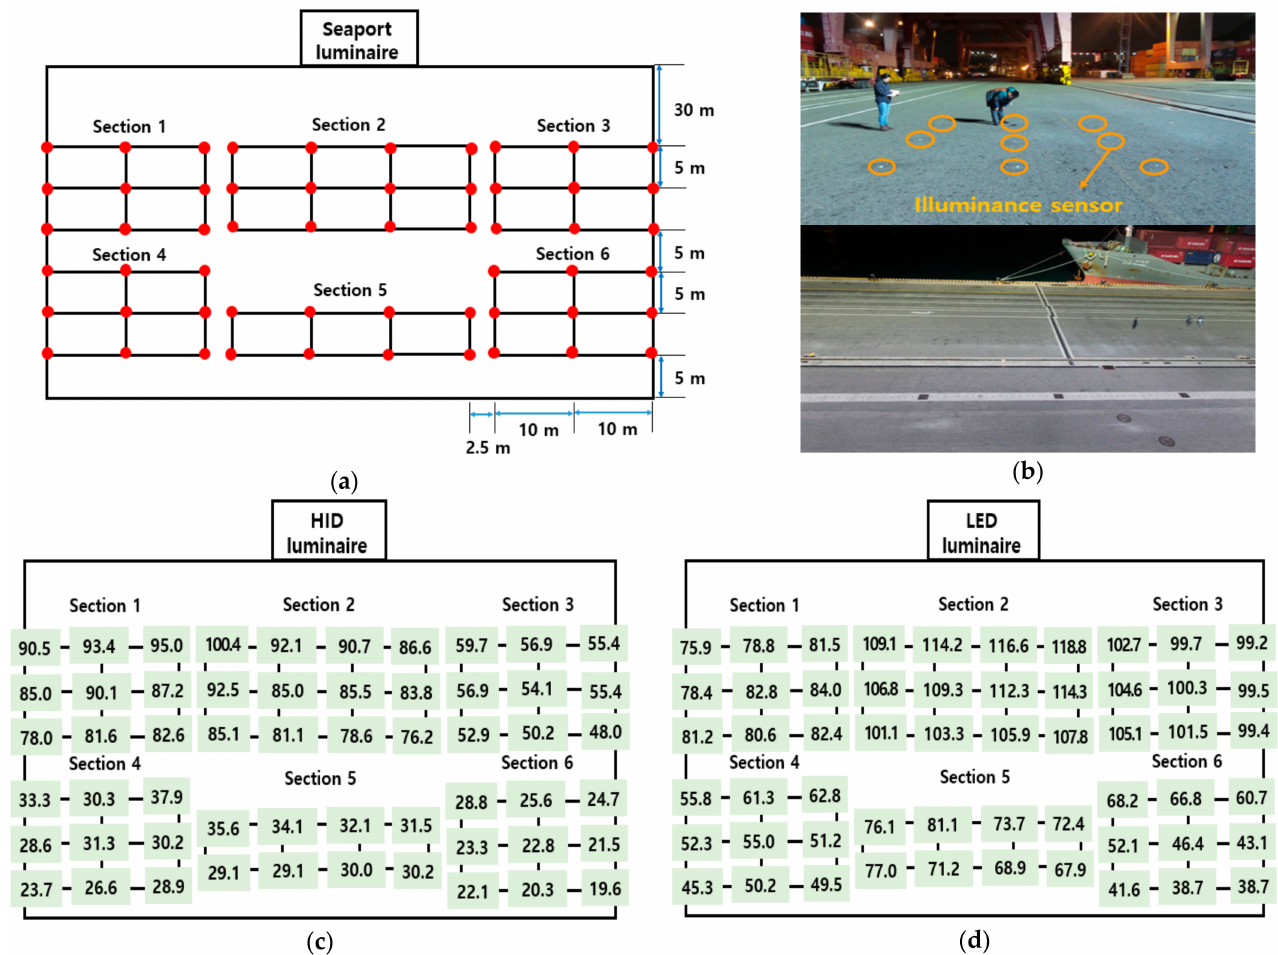
Figure 8. Positions of measurements points in the seaport area ( a ), installation of illuminance sensors at the measurement points ( b ), actual measured illuminance (lx) with HID luminaire ( c ) and actual measured illuminance (lx) with LED luminaire ( d ).